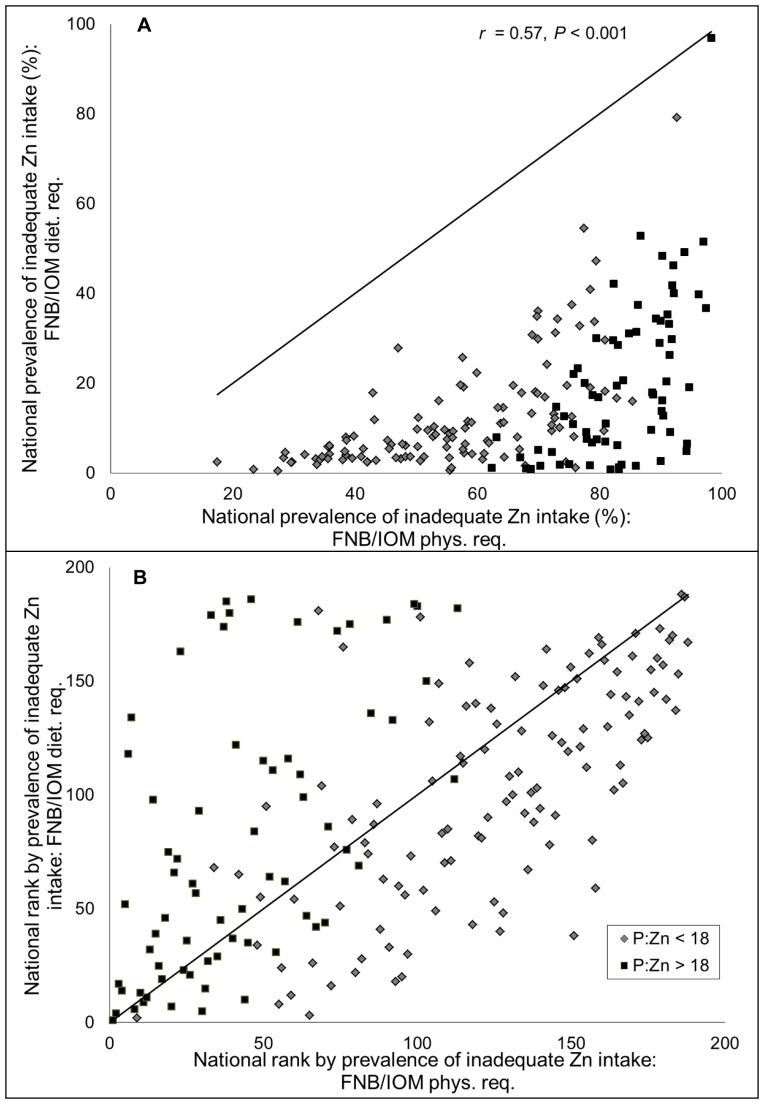
Associations between the (A) national prevalence and (B) country-specific rank order by prevalence of inadequate zinc intake as estimated by different FNB/IOM Zn requirements.Estimates are based on physiological and dietary zinc requirements developed by the Food and Nutrition Board of the Institute of Medicine. The composite nutrient database and a 25% inter-individual CV in intake are used for all estimates. The solid line represents the line of identity (intercept = 0, slope = 1). N = 188 countries. Country rank orders were assigned in descending order, with the country with the highest estimated prevalence of inadequate zinc intake having the lowest rank.